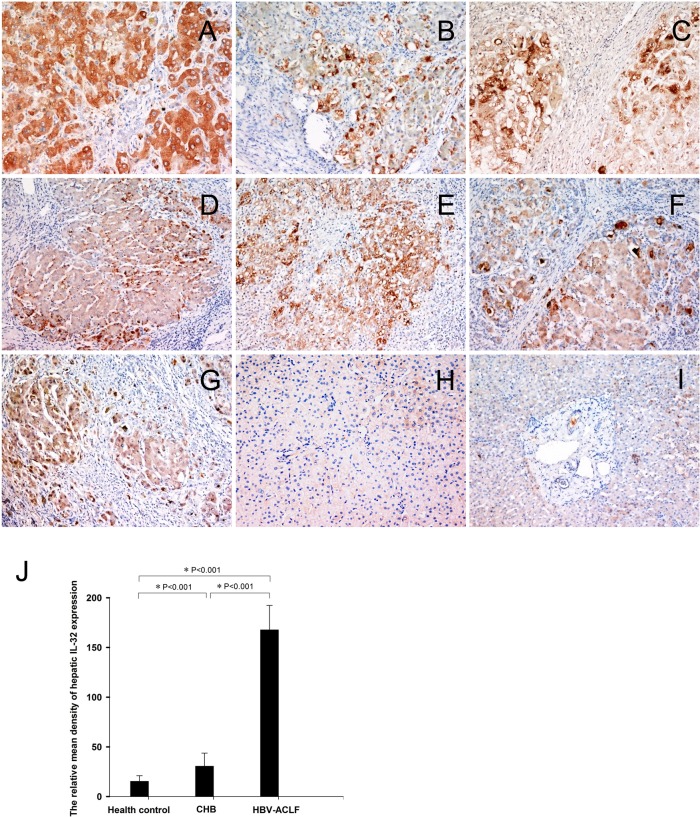
Up-regulated hepatic IL-32 expression in HBV-ACLF patients.IL-32 expression was detected in liver samples from patients with HBV-ACLF (Fig 3, A–G, original magniifcation 200x), mild CHB (Fig 3H, original magnification 200x), and healthy controls (Fig 3I, original magnification 200x) by immunohistochemical staining. Relative mean density analysis indicated that the hepatic B7-H6 expression in HBV-ACLF patients was significantly higher than that in mild CHB patients or healthy controls (P < 0.05) (Fig 3J).